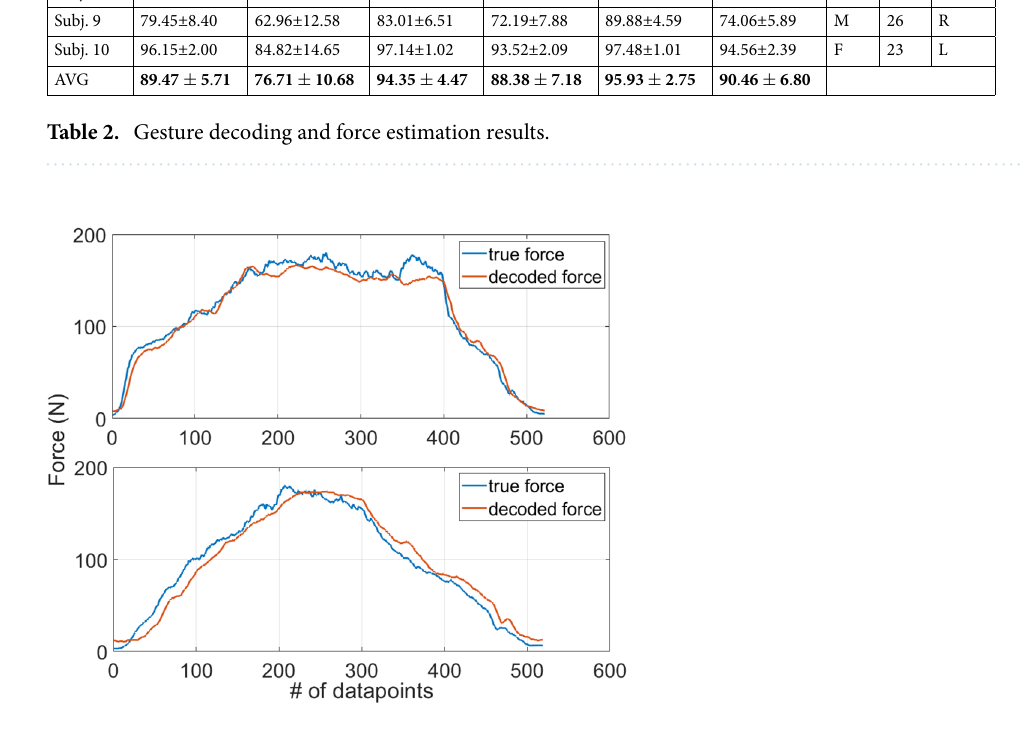
Figure 7. Two examples of decoded clenching force vs the actual clenching force using the LMG data. The forces were decoded using the TMC-ViT model. True force is shown in blue and decoded force is shown in